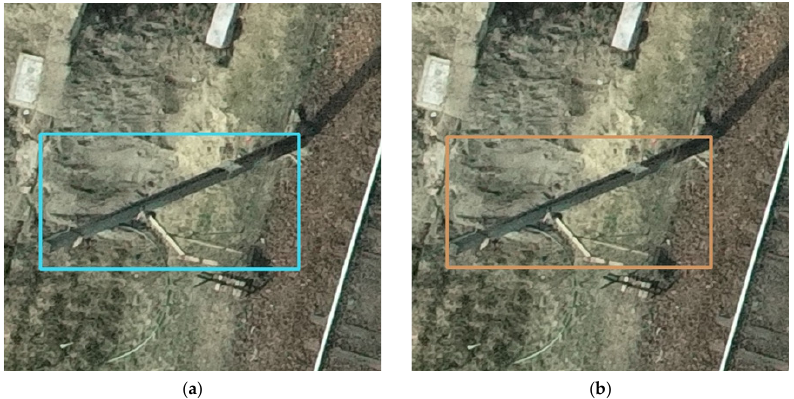
Figure 15. An example of a training dataset for traction poles with IoU = 0.94; ( a ) the bounding box generated from DIM point clouds; ( b ) ground-truth bounding box from TLS point cloud.